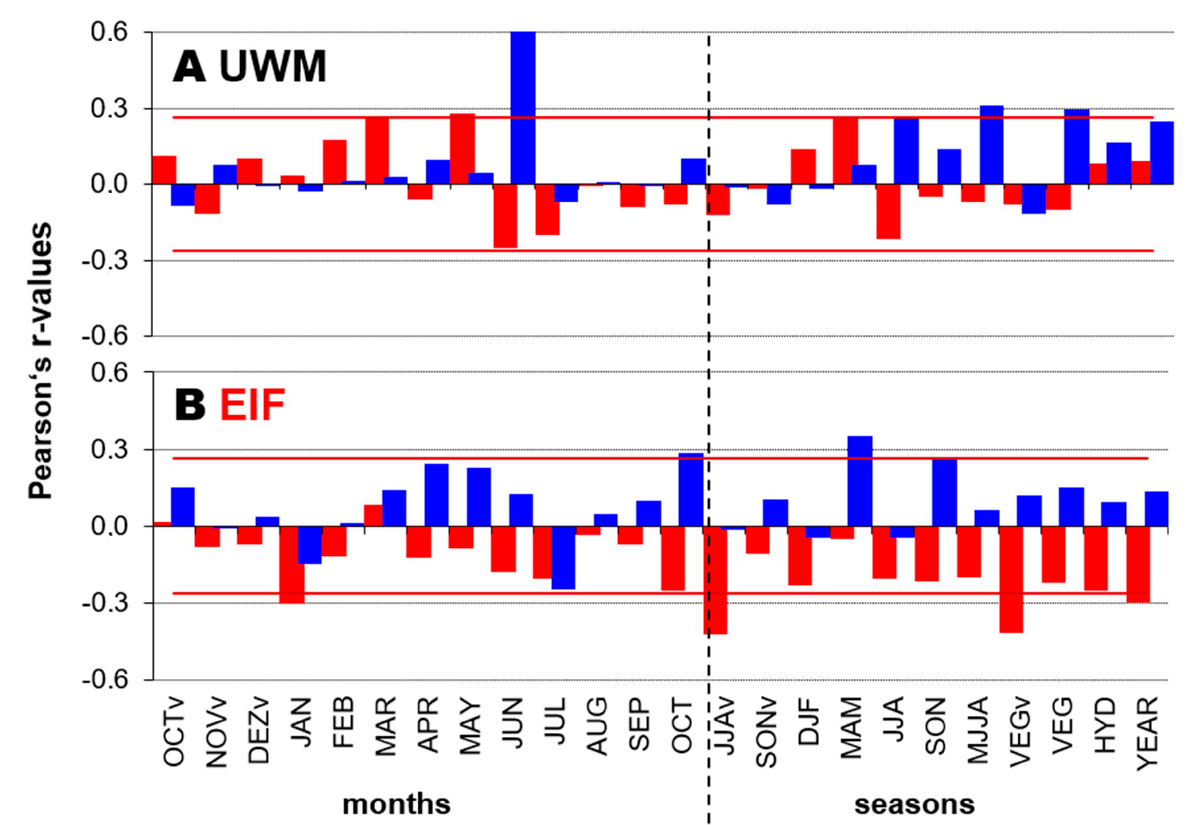
Figure 3. Pearson’s correlations between the monthly and seasonal temperature (red bars)/precipitation (blue bars) series and TRW–chronologies for UWM ( A ) and EIF ( B ). Index v designates months and seasons of the previous year of ring formation. Brown horizontal lines mark the level of significance for 95% with r krit = 0.2616.